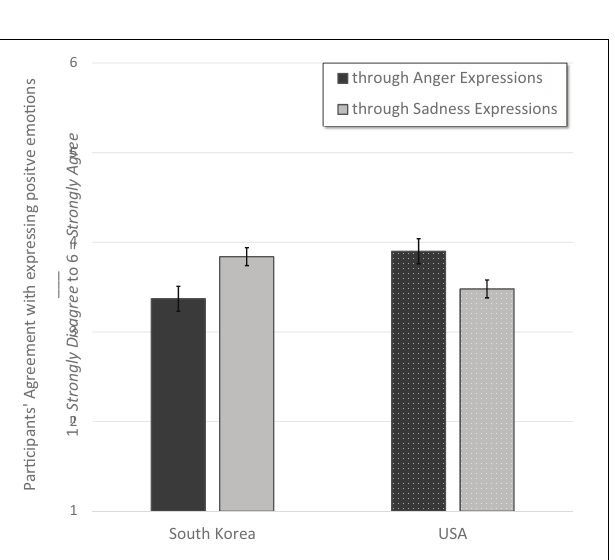
FIGURE 7 | Panel illustrates that South Korean participants reported expressing positive emotions with more sadness and fewer anger expressions than did American participants. Error bars indicate ± 2 standard